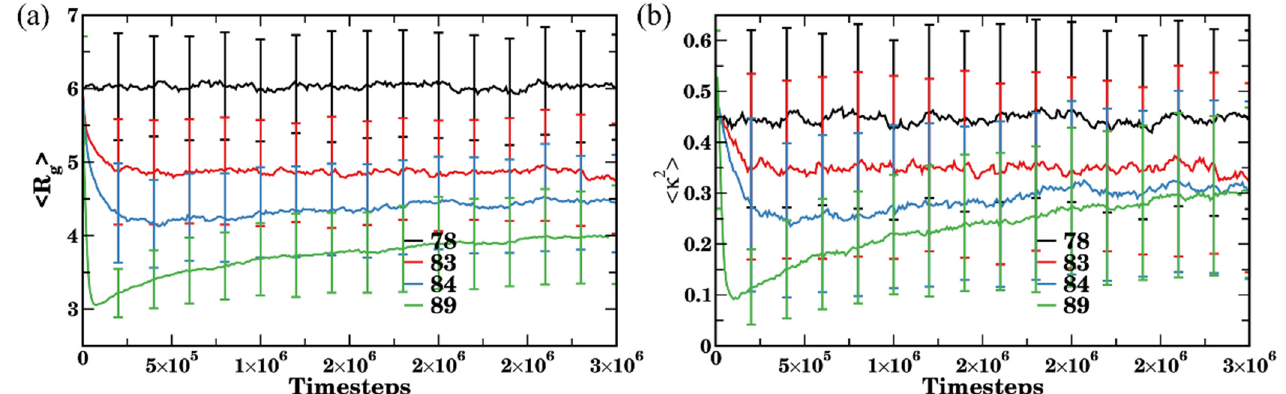
Figure 8. Time evolution of ( a ) radius of gyration and ( b ) shape anisotropy. At each time step, the data are averaged over all n MBB = 77 bottlebrushes in four independent simulation sets, error bars represent standard deviation. Black, red, blue, and green curves correspond to affinities a sc-sol =78, 83, 84, and 89, respectively.